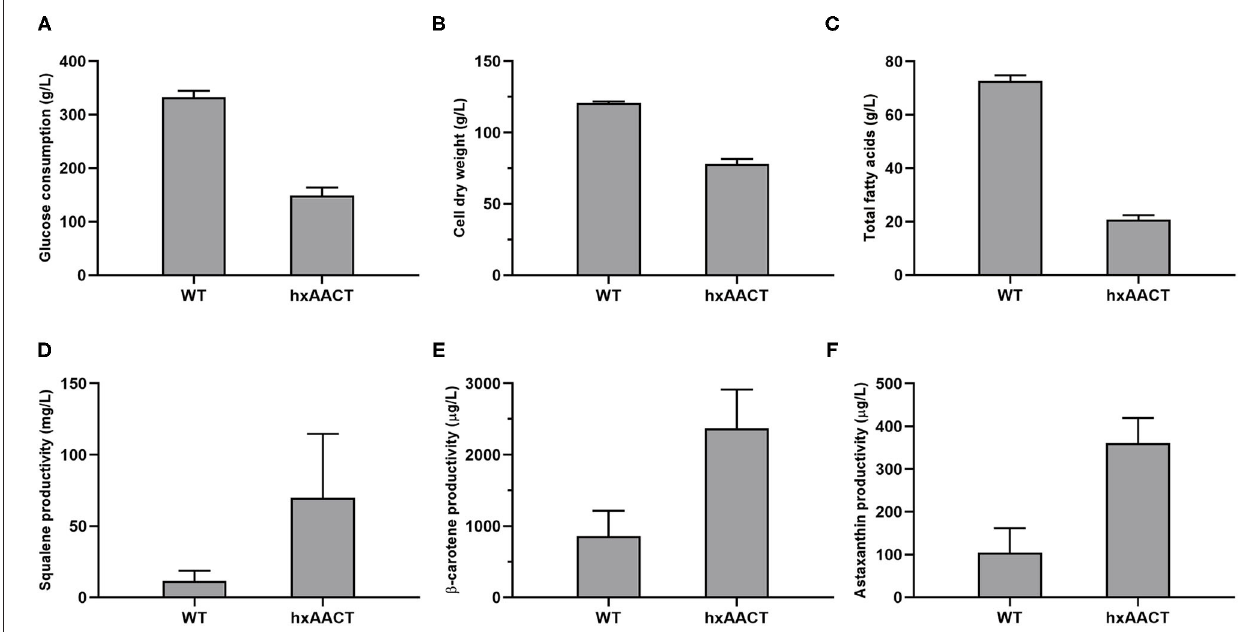
FIGURE 3 | Comparison of cell growth, the accumulation of lipids, and the synthesis of terpenoids between the strain WT and the strain hxAACT at 120h in 500-mL shake flasks. (A) Glucose consumption, (B) CDW, (C) Lipid productivity, (D) Squalene productivity, (E) β -carotene productivity, (F) Astaxanthin productivity. Values and error bars represent the means and standard deviations from triplicate experiments.